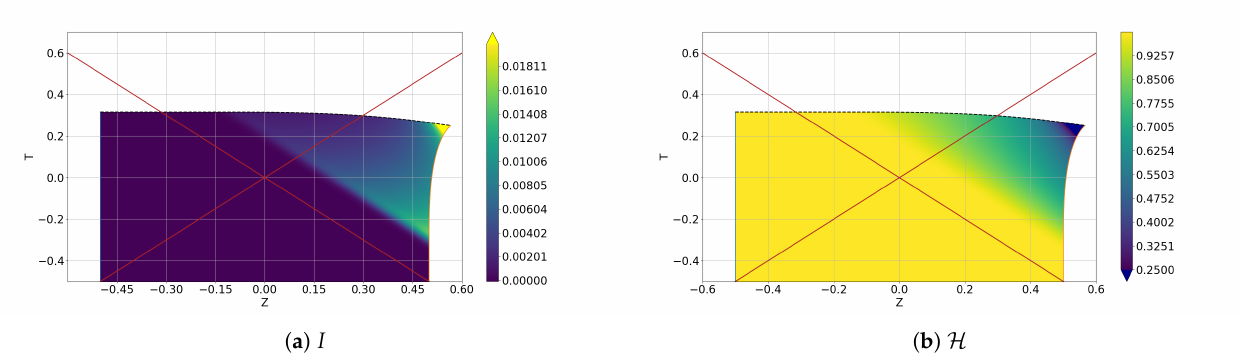
Figure 4. Contour plots of I and H plotted with respect to the semi-invariant T and Z coordinates where a = 3. The dashed line represents the last timeslice.